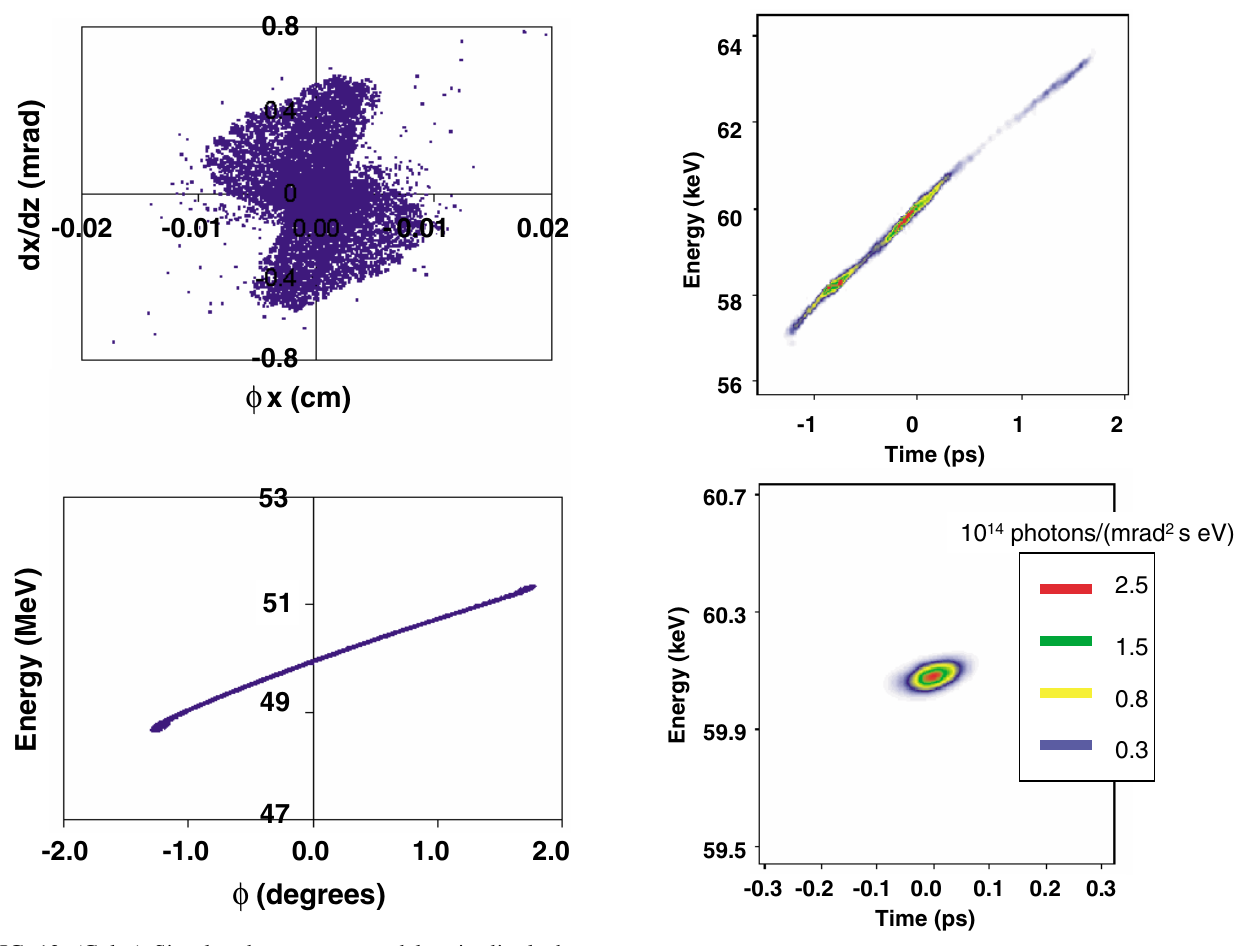
FIG. 13. (Color) Simulated transverse and longitudinal phase space of the electron beam at the interaction point. FIG. 14. (Color) Simulated on-axis x-ray spectrum of the chirped Thomson scattered x rays before (top panel), and after (bottom panel) spectral filtering.